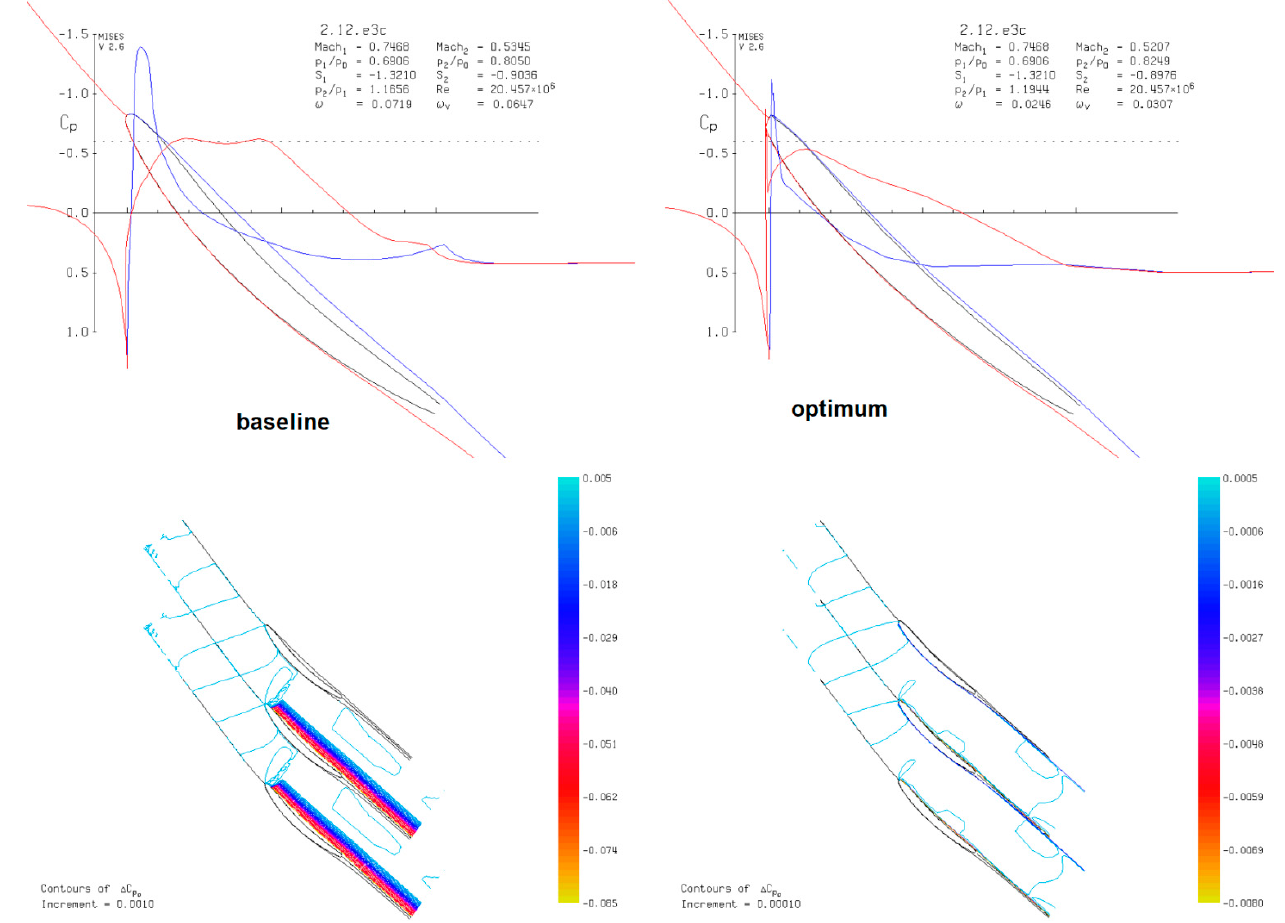
Figure 16. Cp distribution at 25% span for baseline and optimum of E 3 HPC rotor 6 with loss coef.